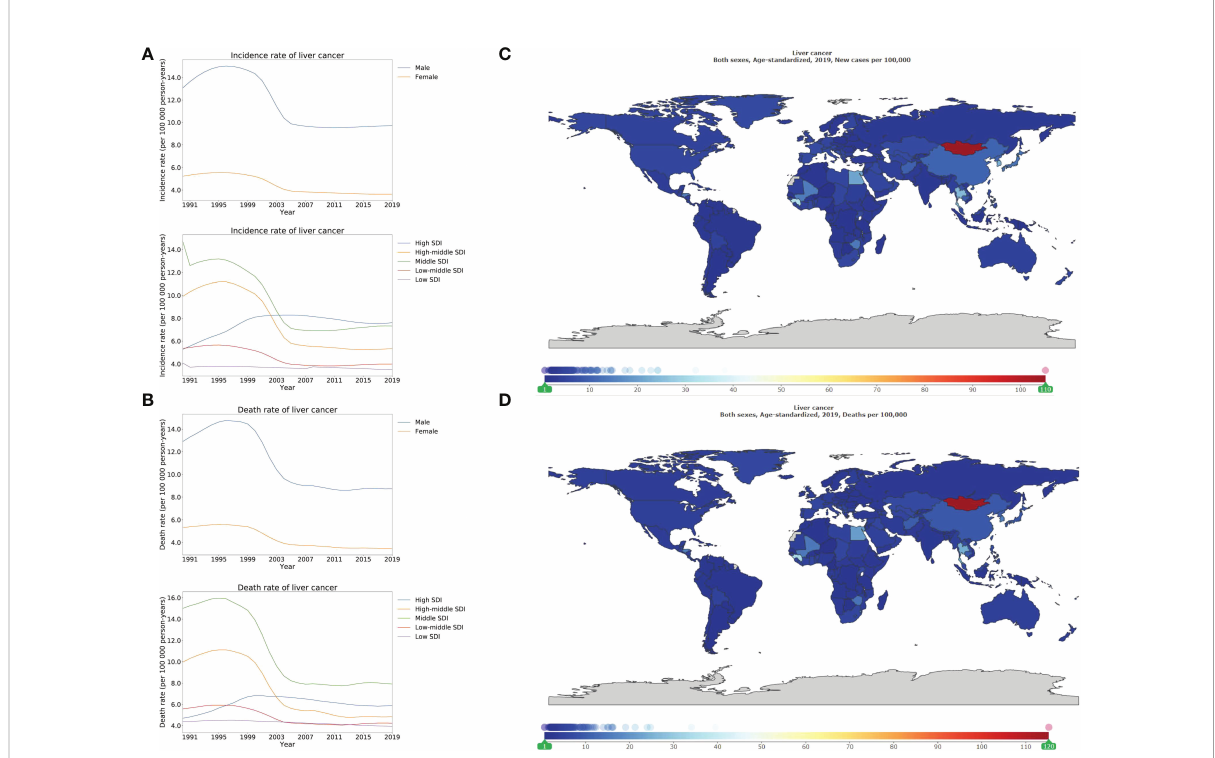
FIGURE 2 Burden of liver cancer for 204 countries and territories. Age-standardized incidence (A) and death (B) rate per 100000 population of liver cancer from 1990 through 2019 by country and territory, strati fi ed by sex or SDI; age-standardized incidence (C) and death (D) rate of liver cancer per 100000 person-years by country and territory, in 2019. The maps in (C) and (D) were generated by GBD 2019